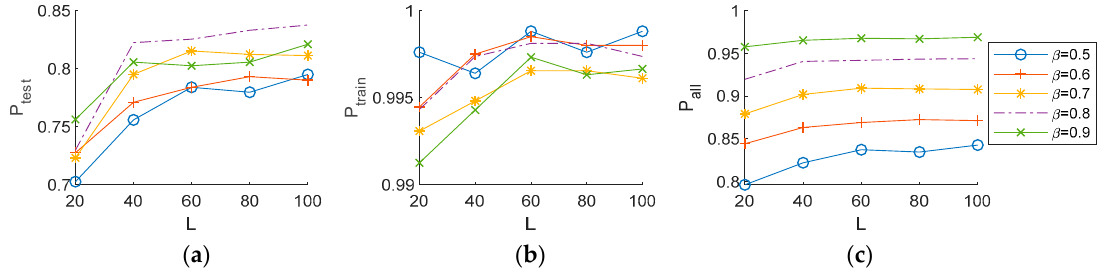
models. As can be seen from the figures, when the image size L is as low as 20, the test accuracy